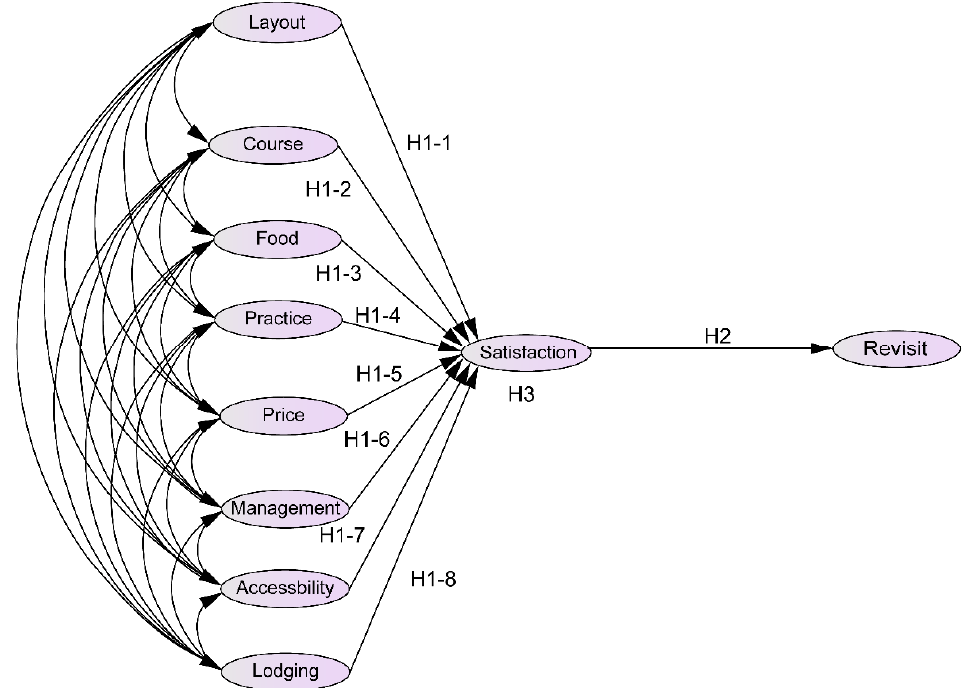
Figure 1. Research model.